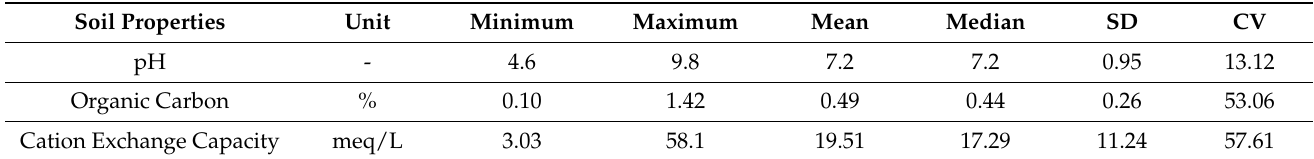
Table 3. Descriptive statistics of the continuous soil